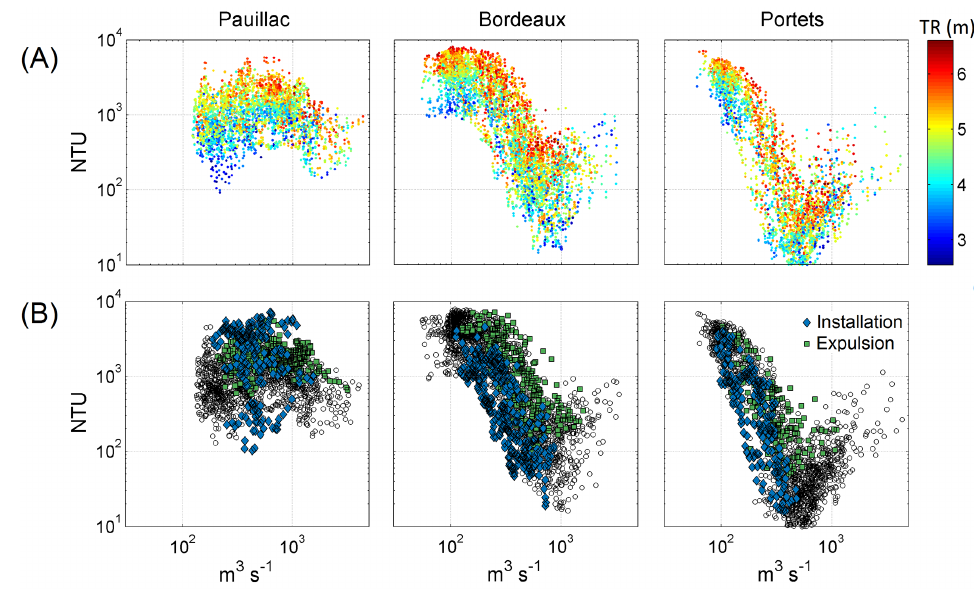
Figure 9. Tidally averaged turbidity (a) and daily averaged turbidity (b) as a function of 3-day averaged river flow for the MAGEST stations of Pauillac, Bordeaux and Portets (log-log representation). (a) Values are classified as a function of tidal range (TR). (b) Values correspond to the periods of installation (blue diamonds) and expulsion (green square) of the TMZ.